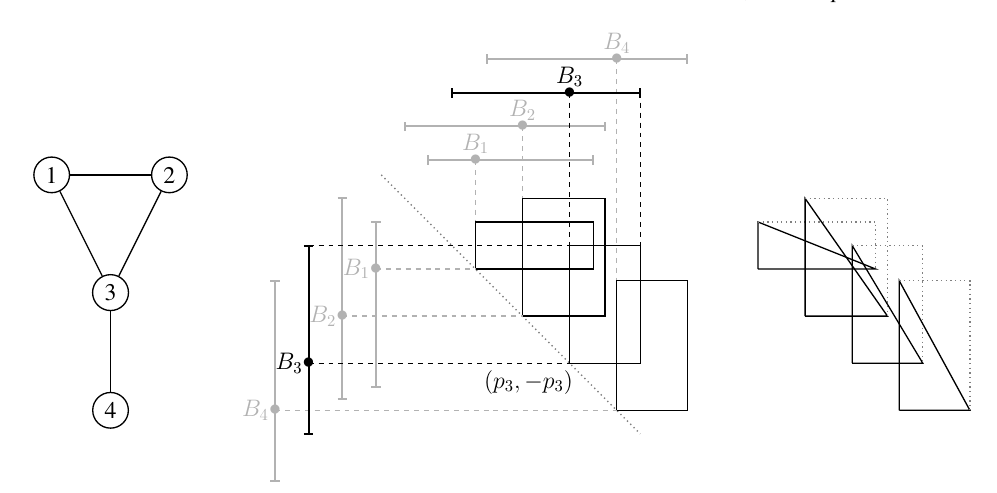
Fig. 1: An example of a graph in p -B OX (1) (left) with its intersection model with boxes (center) and triangles (right hand